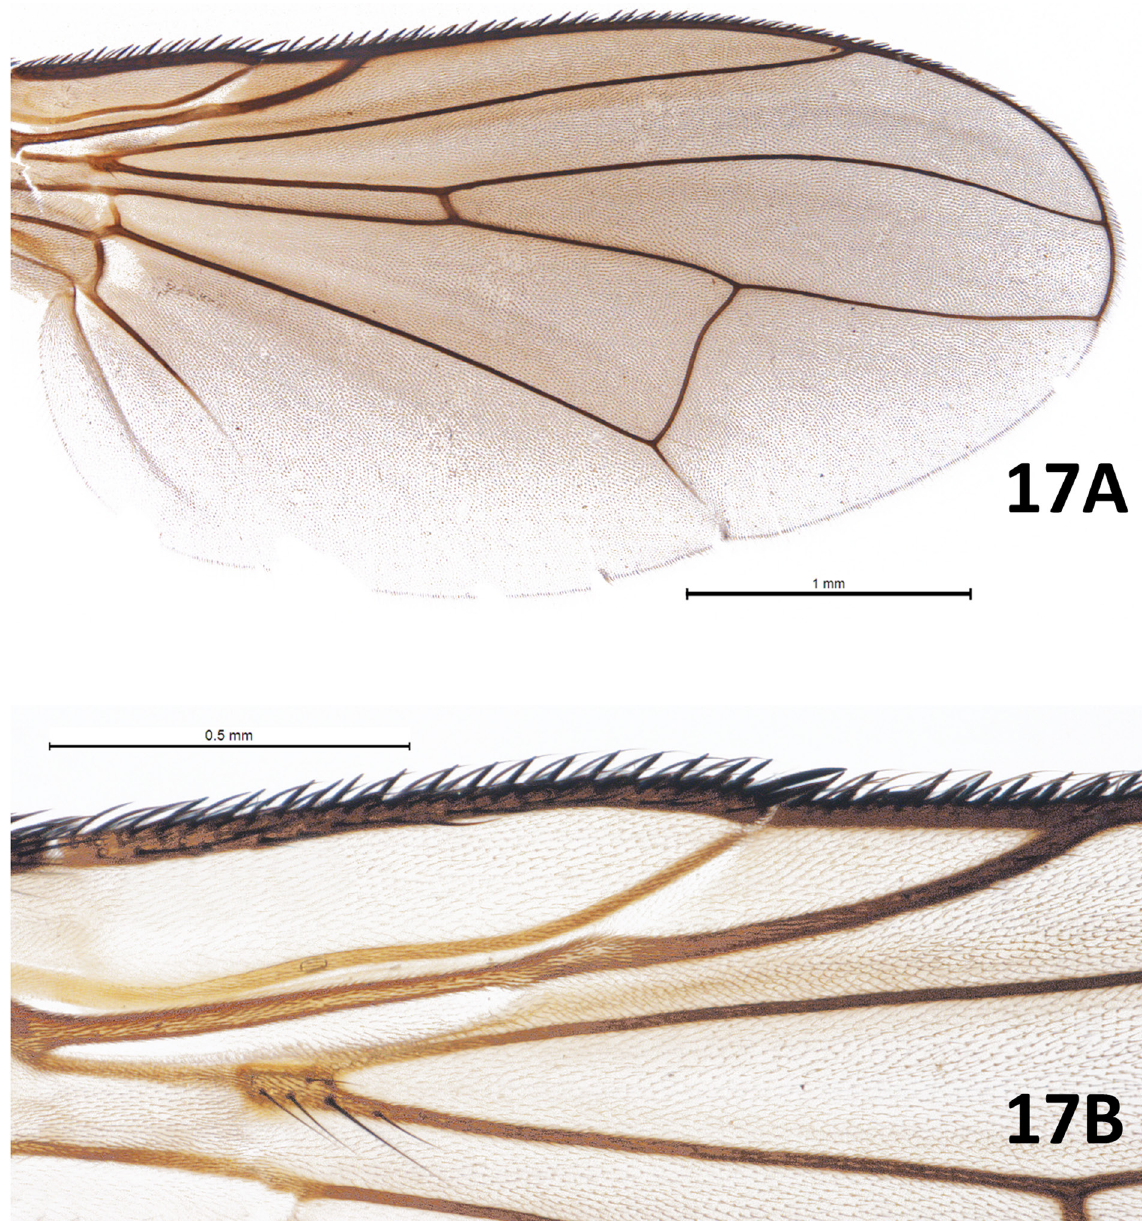
Fig. 17. ♀ of Thaumasiochaeta Stein, 1911. A . Wing, dorsal view. B . Detail of wing showing CS1‒2, dorsal